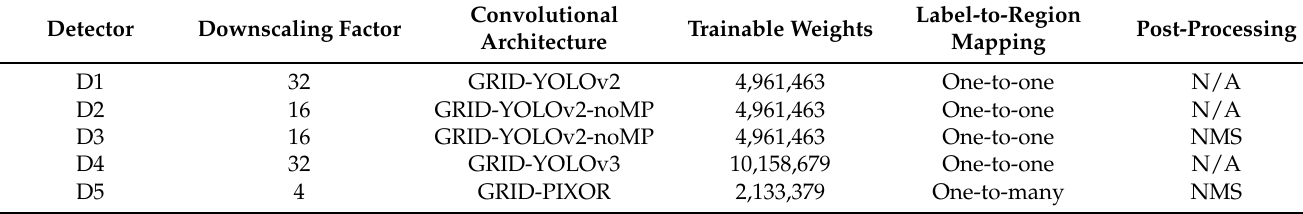
Table 1. Summary of the five detectors